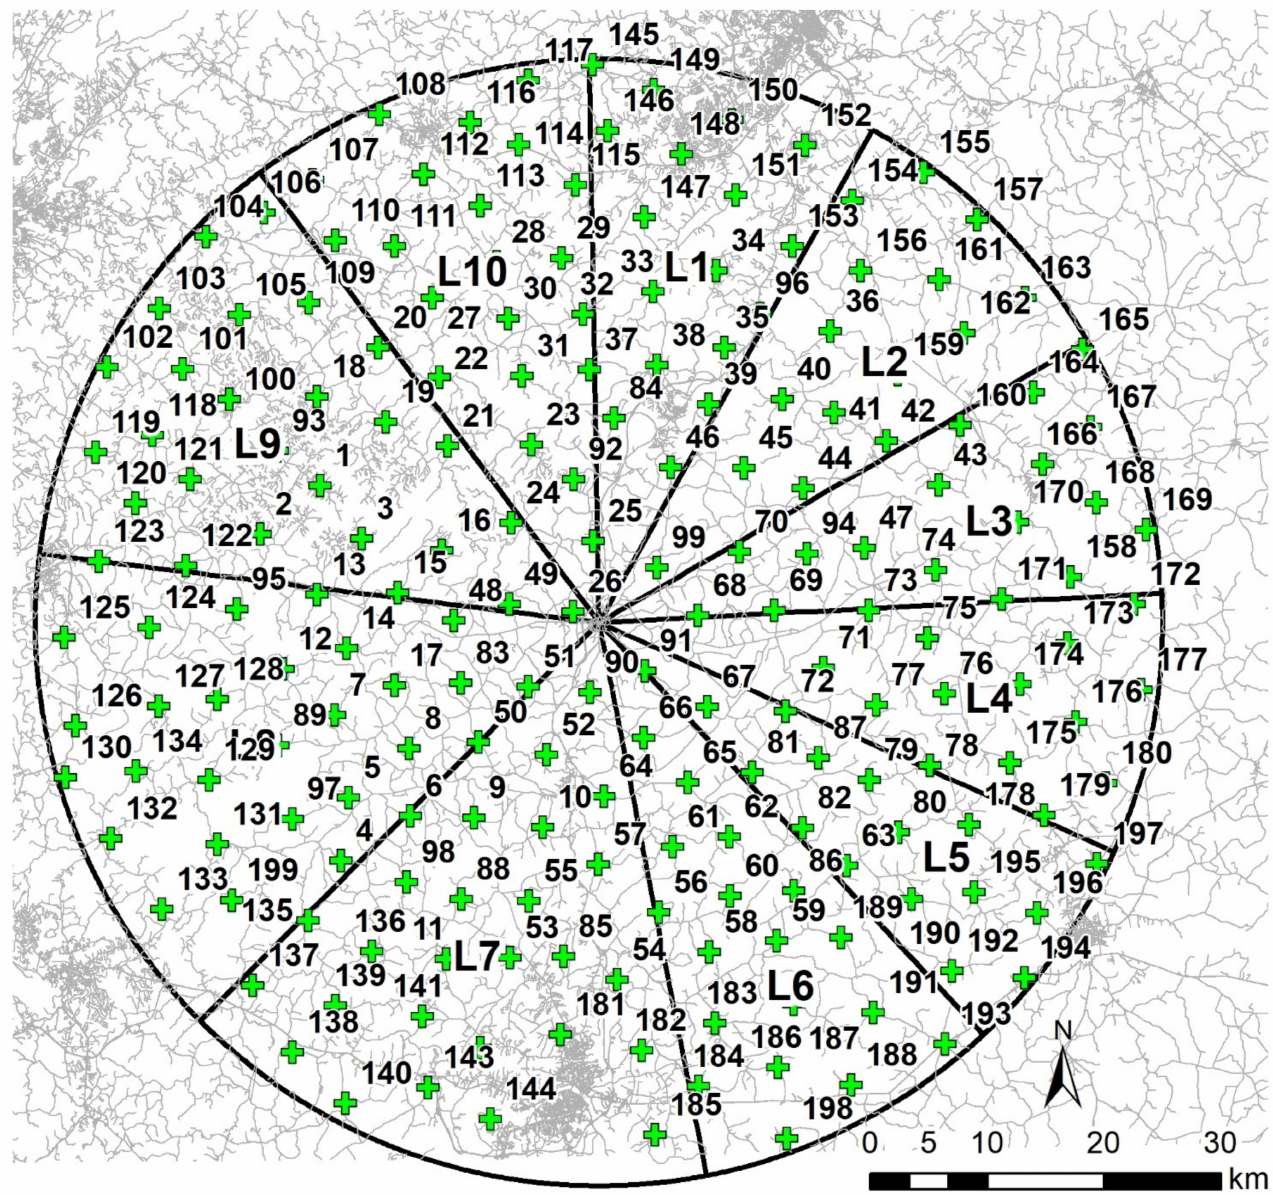
Figure 4. Assignment of load-out sequences (L1 to L10) for the subareas in the 10-load-out-operation simulation for the 199 SSLs in the Gretna